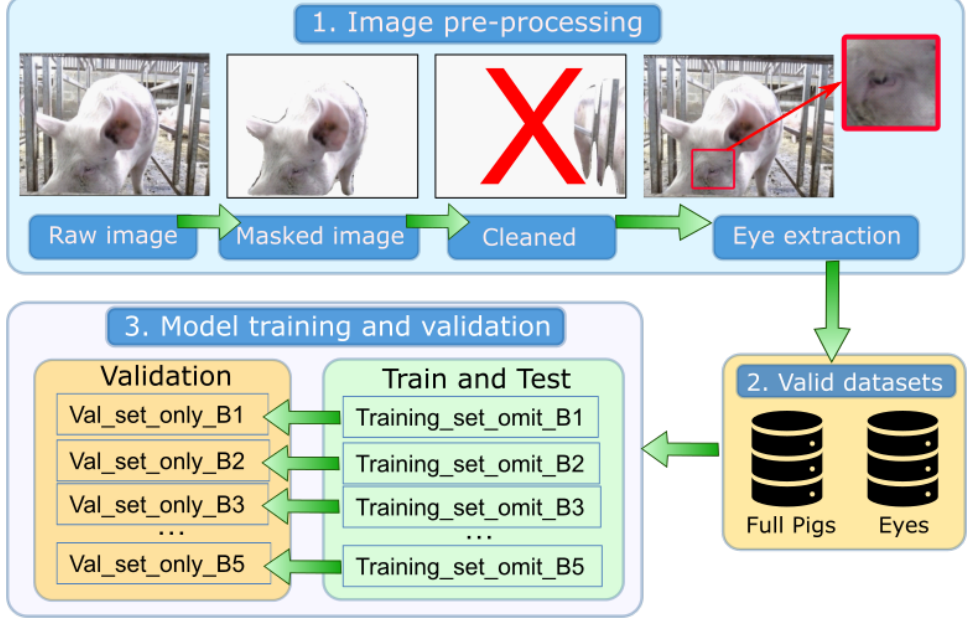
Figure 3. Pipeline of the process showing the preprocessing of the raw images to generate two datasets of valid images that are then used to create leave-one-out training and validation datasets where B N (e.g., B1, B2, etc.) represents the batch